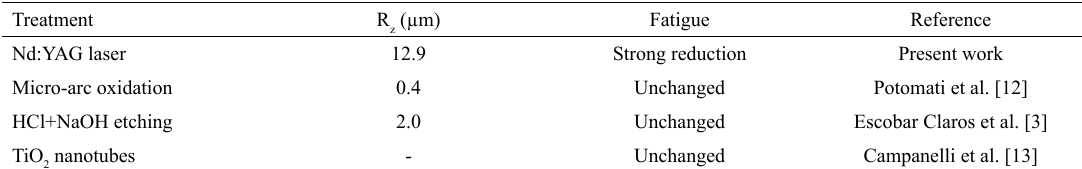
Table 4. Comparison of different surface modification techniques on Ti-6Al-4V ELI.